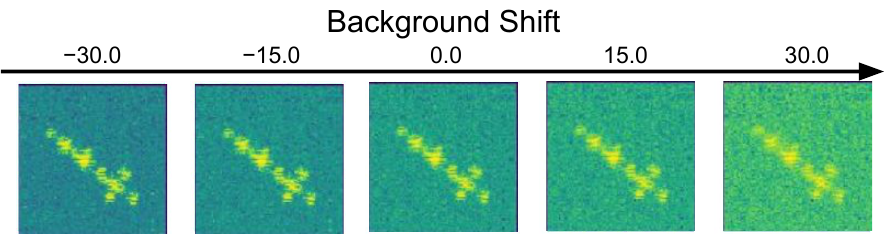
Figure 8. Background shift data